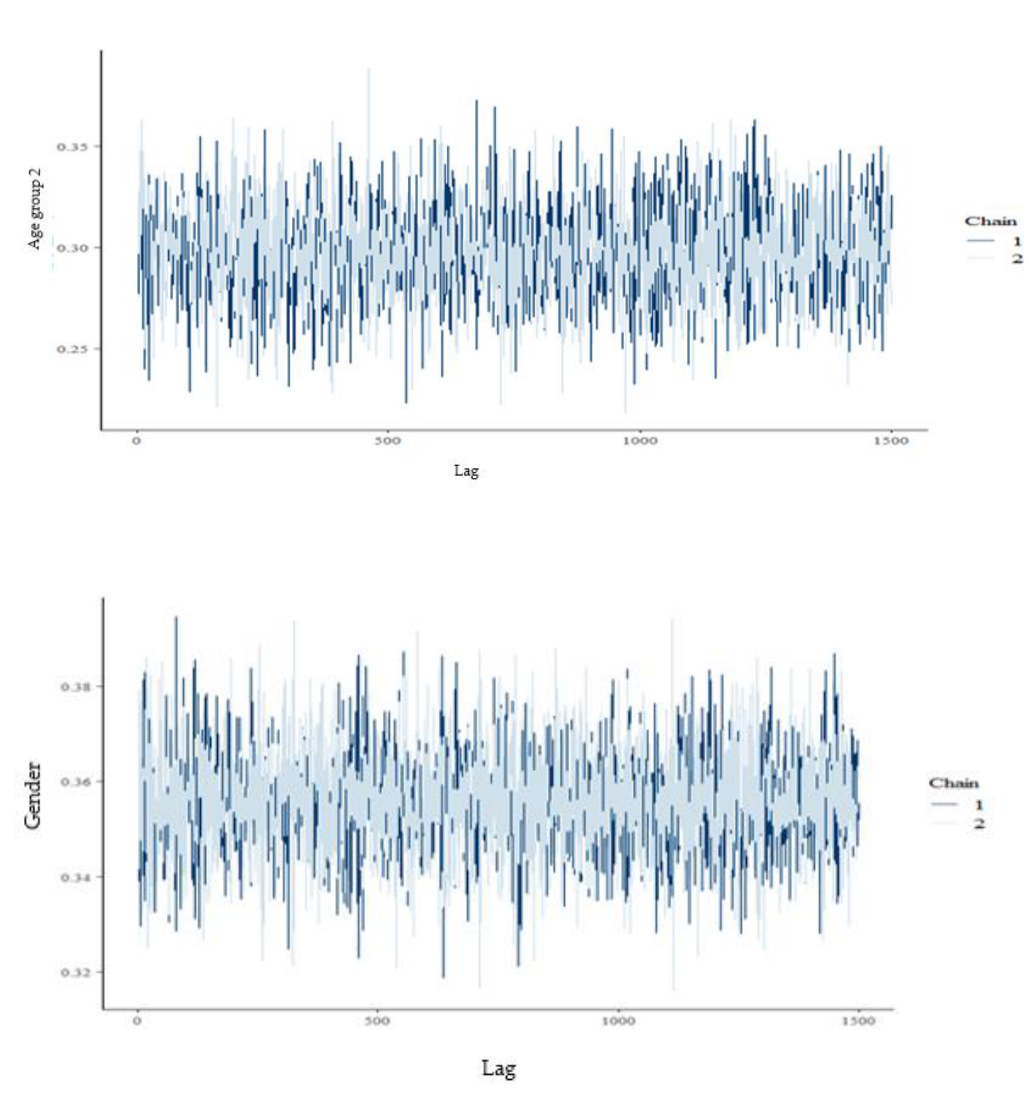
Figure 1. Trace plots for age group two and gender of the respondents. Chain 1 and chain 2 refer to the two Markov chains used in the MCMC techniques for all our estimations.